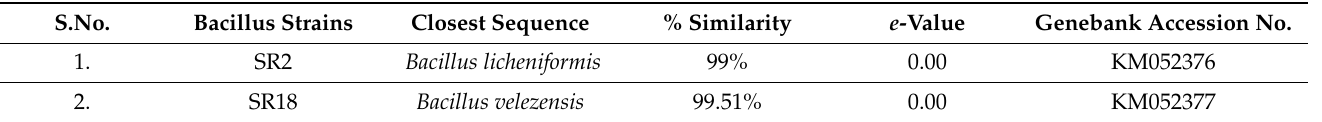
Table 3. Closest sequences, % similarity and accession no. of the potential Bacillus strains by 16 s rRNA gene